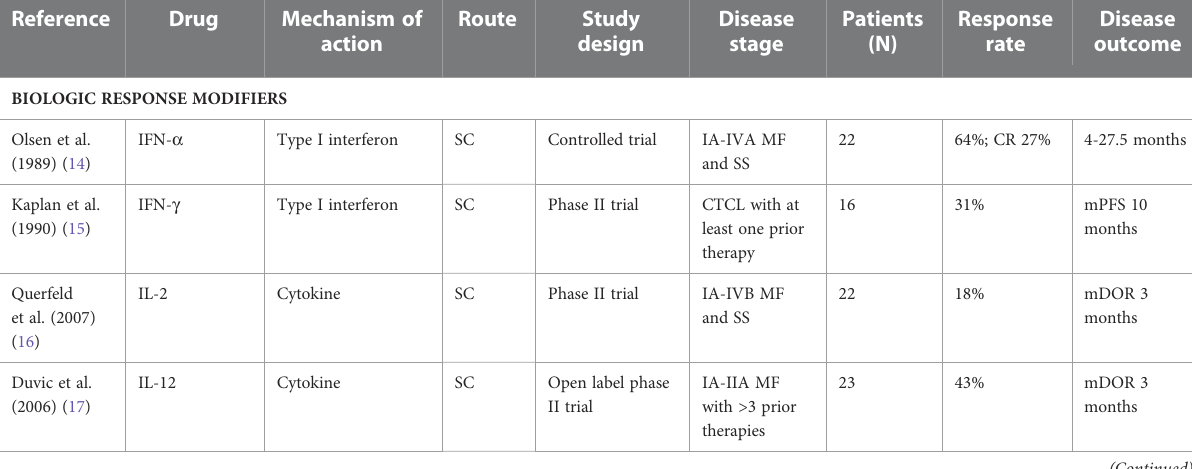
TABLE 2 Biologic response modi fi ers, cellular immunotherapy, immune checkpoint inhibitors, and toll-like receptor agonists for the treatment of CTCL.